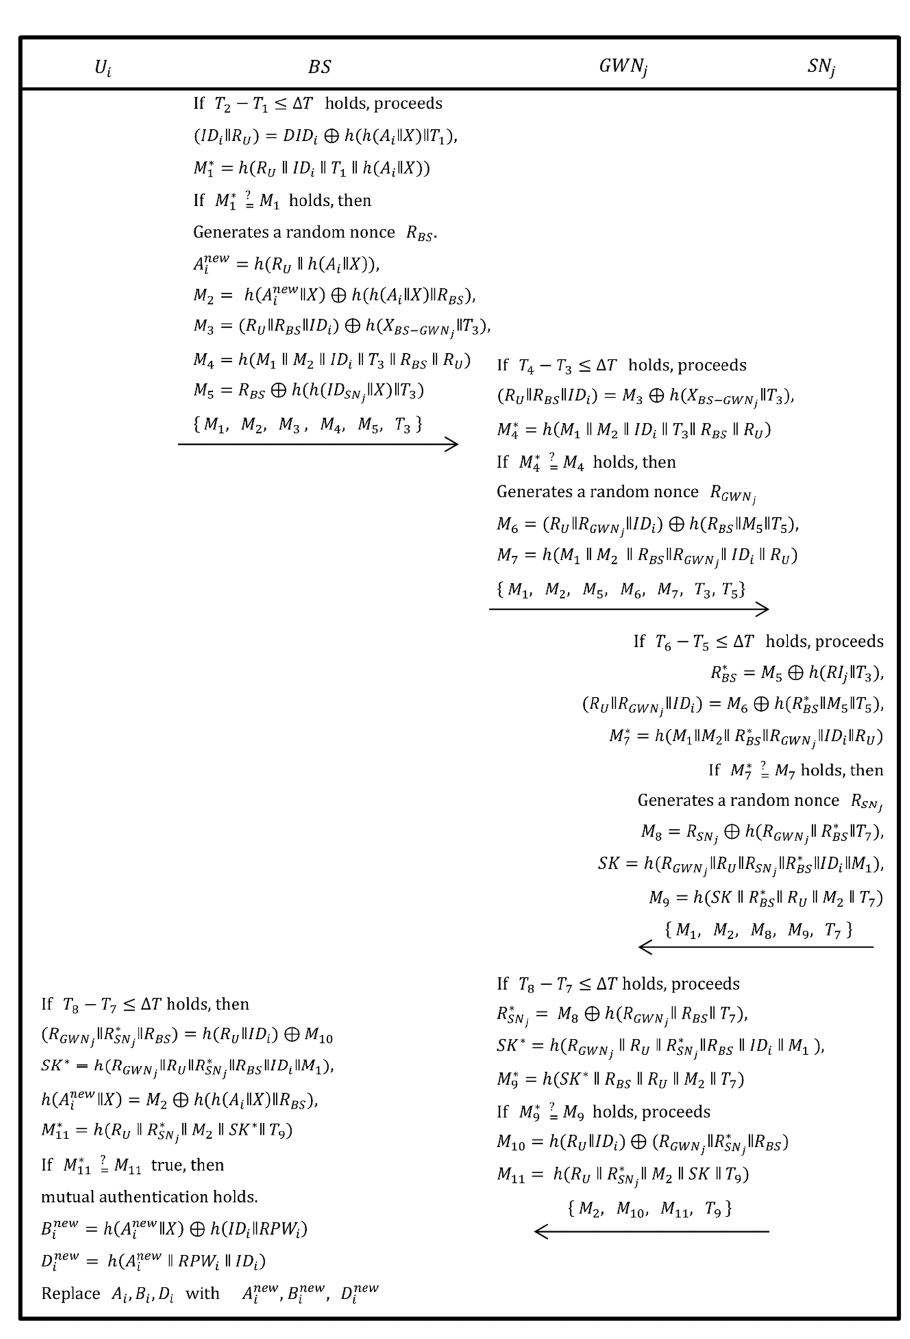
Figure 7. Authentication and key agreement phase of the proposed scheme.